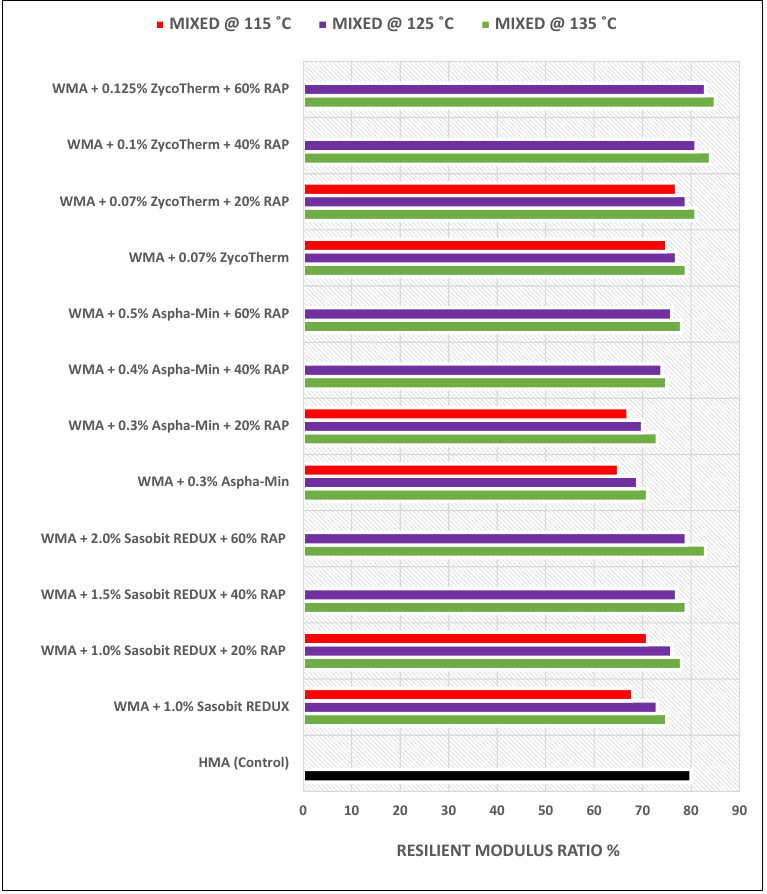
Figure 21. The results of resilient modulus ratio (RM R ) test.